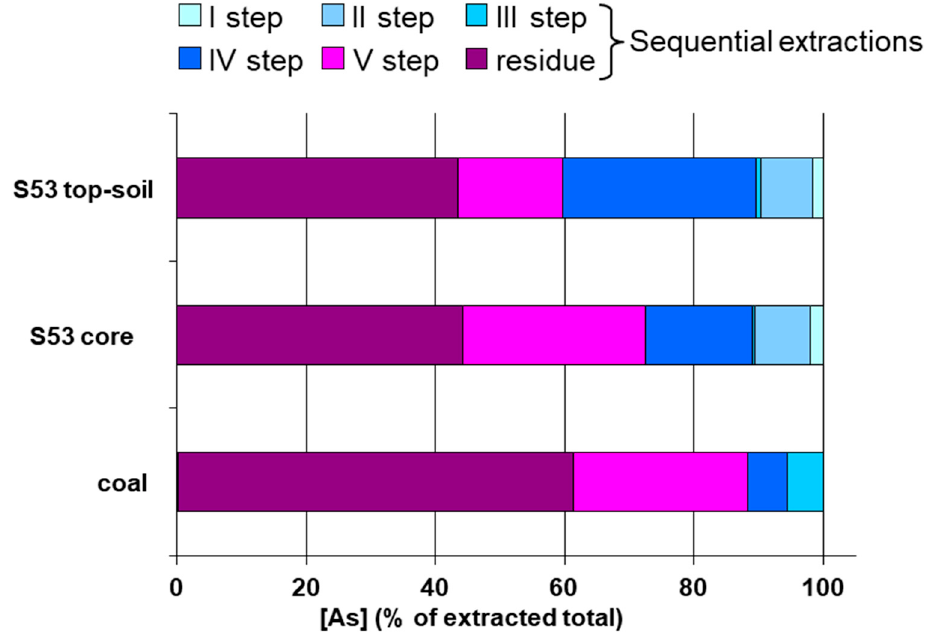
Figure 3. Comparison of the As release profiles in soil samples from point S53 and its surrounding area with those found in the coal samples made available by the Ente Nazionale per l'Energia Elettrica (ENEL) power company.